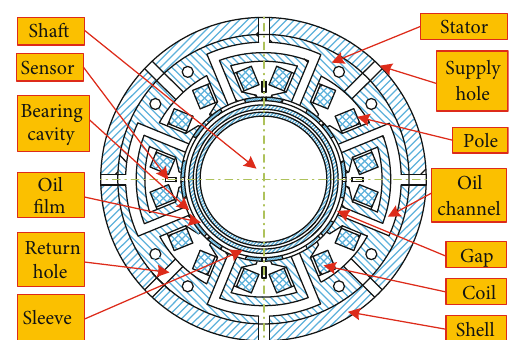
Figure 2: Full pro fi le of radial bearing.